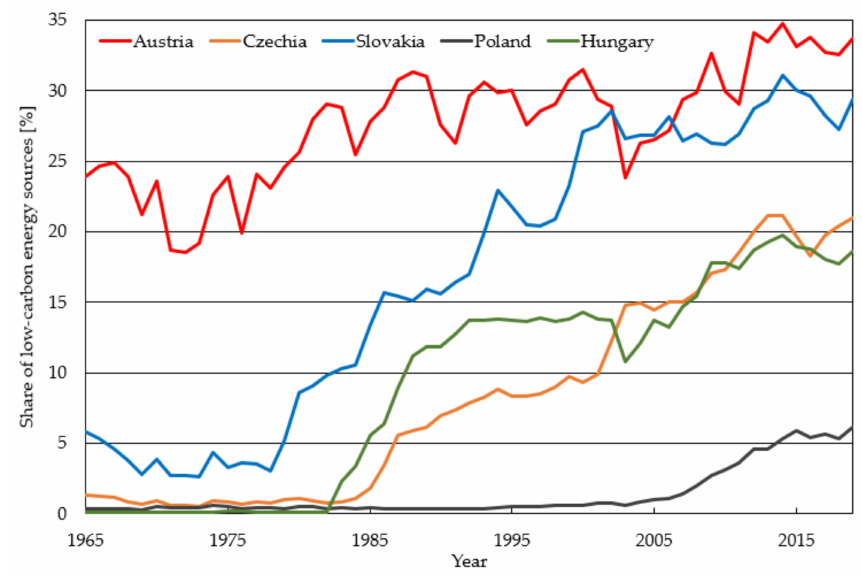
Figure 14. Share of low-emission sources in primary energy consumption (1965–2019) [49]. In the production of electricity, where the development is shown in Figure 15, the situation is different. Slovakia and Austria are in first and second place with almost 80% use of low-emission sources for electricity production, with Hungary following 62%, the Czech Republic 49% and Poland 16%. In this comparison, two factors come to the fore—the use of nuclear energy (Slovakia, Czechia, Hungary) and the existence of significant potential for RES in the country (Austria).